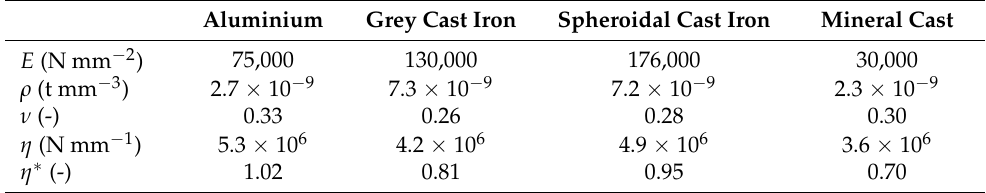
(cid:112) E / ρ is listed. In the last 10 6 . ×